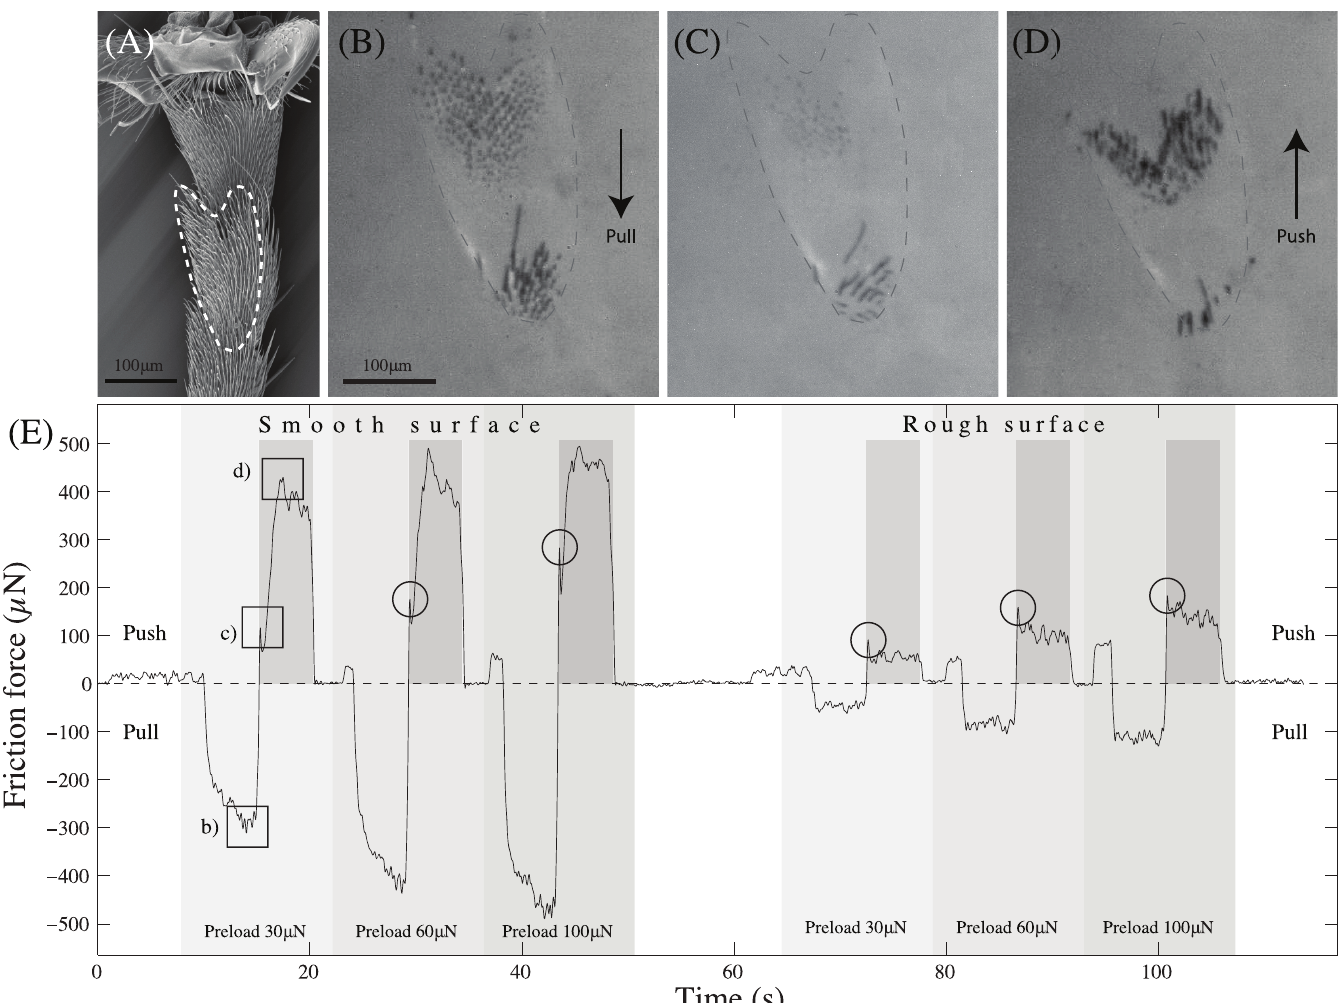
Fig 9. Typical friction force trace from tarsal hair fields against a smooth and rough surface. (A) SEM image showing the tarsal hairs of the 3 rd and 4 th tarsomeres (the part in contact with the surface is outlined with a dashed line). (B) Contact area of the hairs in pulling orientation using coaxial illumination on a stereo-microscope. (C) Hairs at the point of buckling. (D) Hairs re-orientated under pushing shear forces. (E) Force trace of tarsal hairs under different preloads and shearing directions on smooth and rough surfaces. Images in sub-figures (B-D) were taken at the points marked with squares in the raw trace curve. Circles mark characteristic ‘ kinks ’ in the force curve indicating the buckling of the hairs. Darker shaded regions indicate the time period during which the motorised stage moved the sample in the pushing